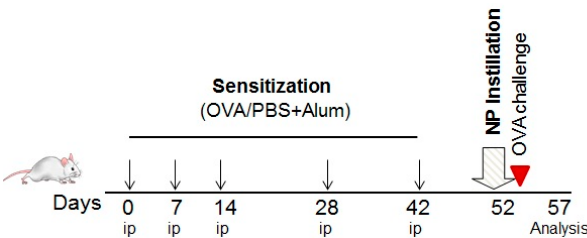
Figure 9. Experimental scheme for ovalbumin sensitization, NPs administration, and ovalbumin challenge. OVA, ovalbumin; PBS, Dulbecco’s phosphate buffer saline; Alum, aluminum hydroxide; ip, intraperitoneal injection.